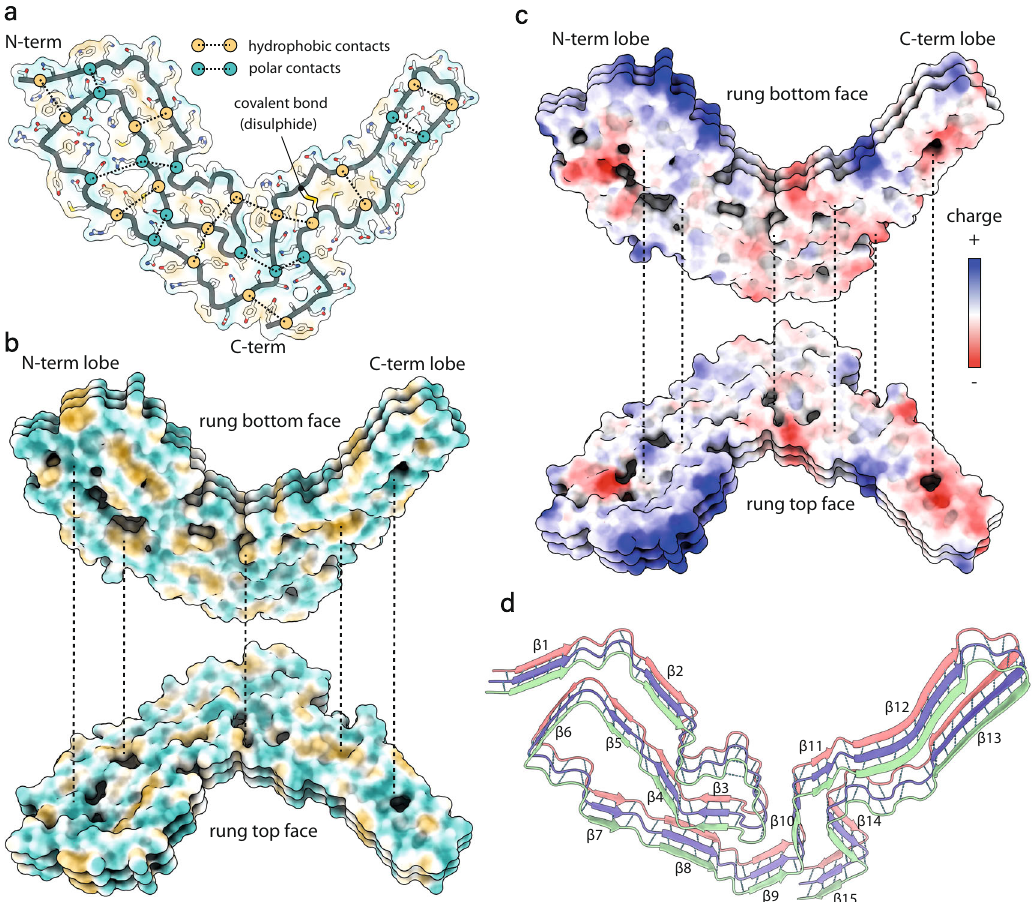
Fig. 2 Intra- and inter-chain interactions stabilising the RML prion fi bril. a Schematic depiction of the alternating polar and non-polar lateral contacts that stabilise a single PrP monomer in the fi bril. Transparent surface representation is coloured by hydrophobicity (hydrophobic, yellow; hydrophilic, teal). Protein backbone is shown with cartoon (licorice) representation and amino acid side chains as white sticks coloured by heteroatom (O, red; N, blue; S, yellow). b Butter fl y view of the top and bottom surface of each rung, coloured as in a . Dotted lines indicate longitudinally connecting regions in the assembly. c Butter fl y view of charge distribution in the assembly. Dotted lines as in b . d Ribbon representation of 3 amyloid rungs, with indicated β -sheets and inter-chain hydrogen bonds (dotted